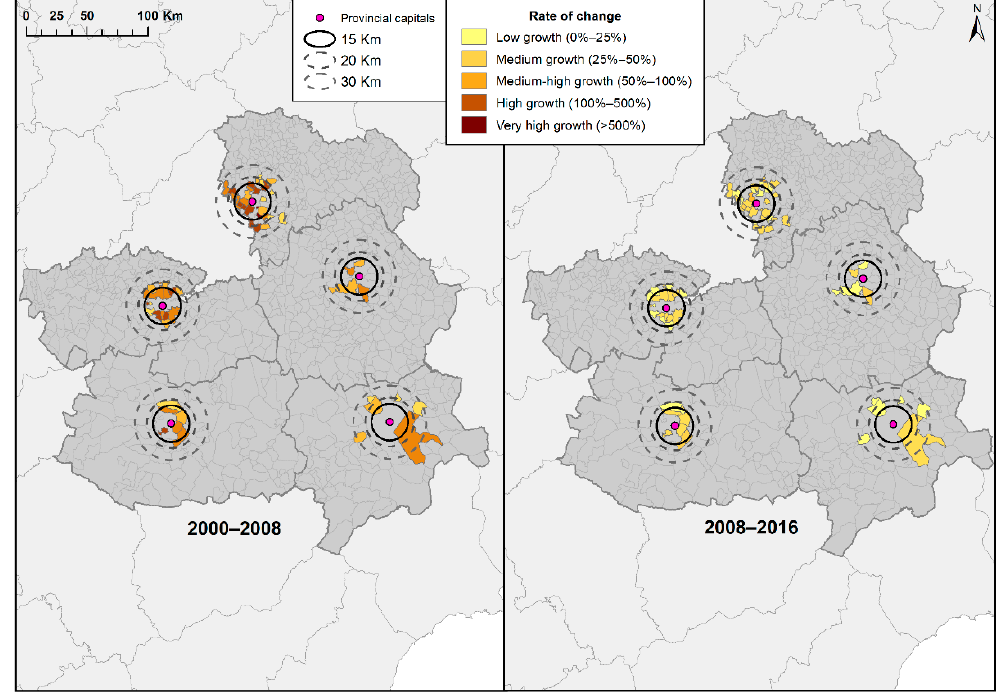
Figure 7. Rate of change in real estate 2000–2008 and 2008–2016. The processes in the first period, which clearly represent the “prodigious decade” of Spanish urban growth [68], helped consolidate the model of a sprawling, low-density city. They feature urban landscapes typified by developments of single-family dwellings. These new patterns of spatial organization generate an inefficient, segregated and unsustainable urban space